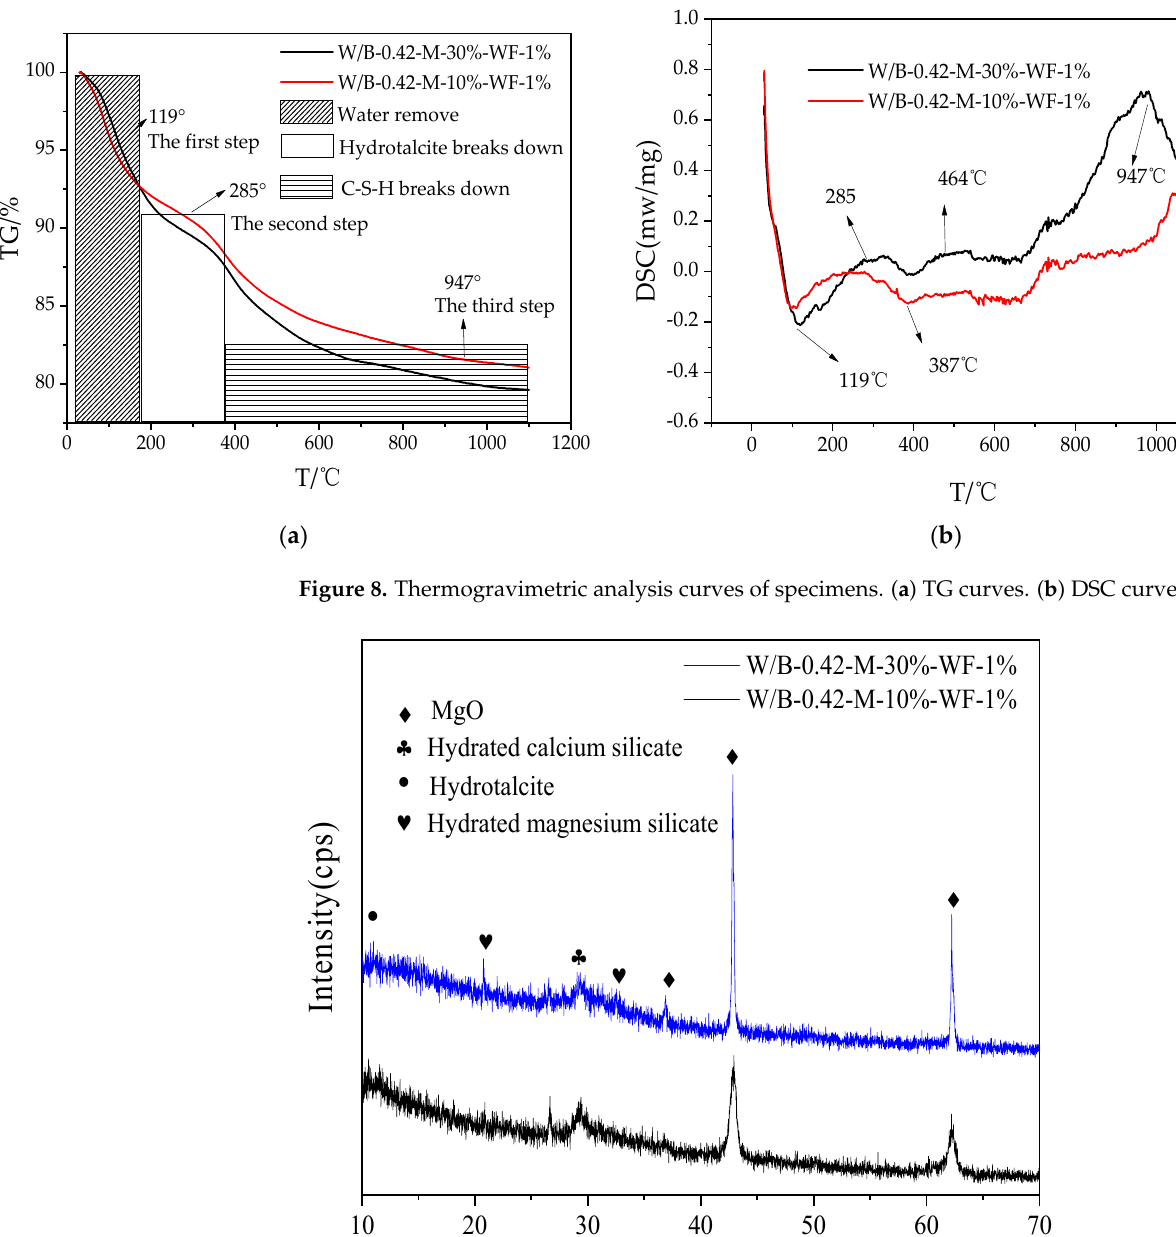
Figure 7. The SEM morphology of alkali-activated blast furnace slag powder with MgO. ( a ) With 10% MgO-3 d. ( b ) With 10% MgO-28 d. ( c ) With 30% MgO-3 d. ( d ) With 30% MgO-28 d.